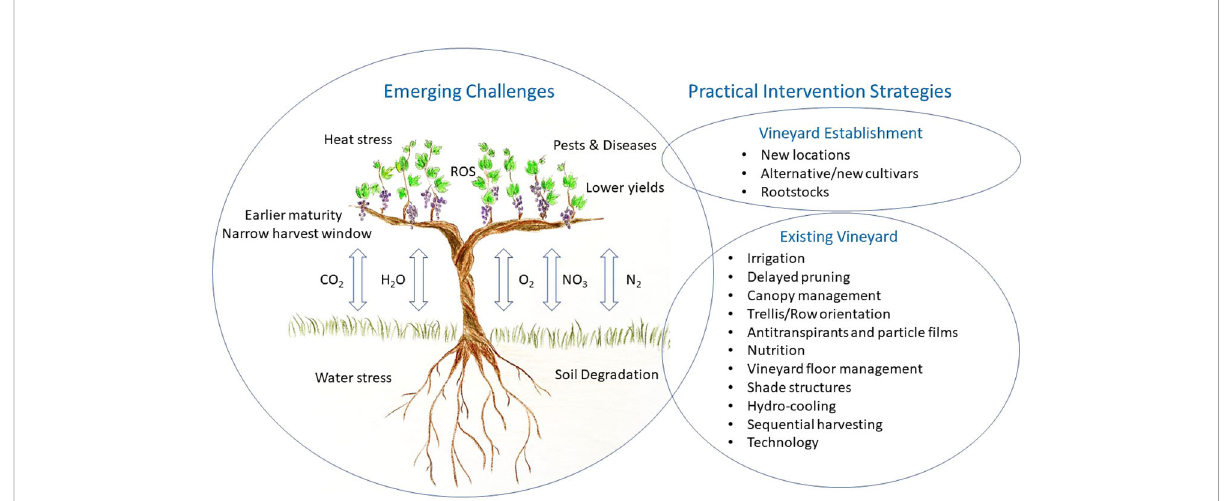
FIGURE 1 Summary of emerging challenges related to climate change and potential practical intervention strategies for the viticulture industry to